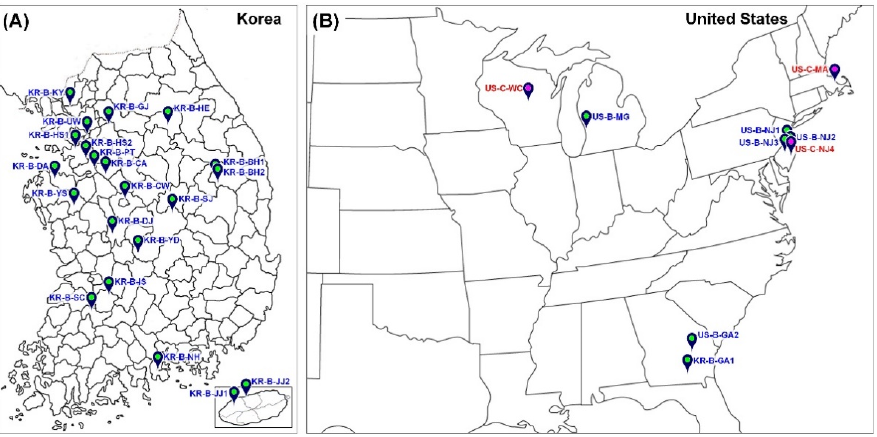
Figure 1. Sampling collection sites of Dasineura oxycoccana. ( A ) South Korea. ( B ) USA. Detailed information of locations is described in Supplementary Materials Table